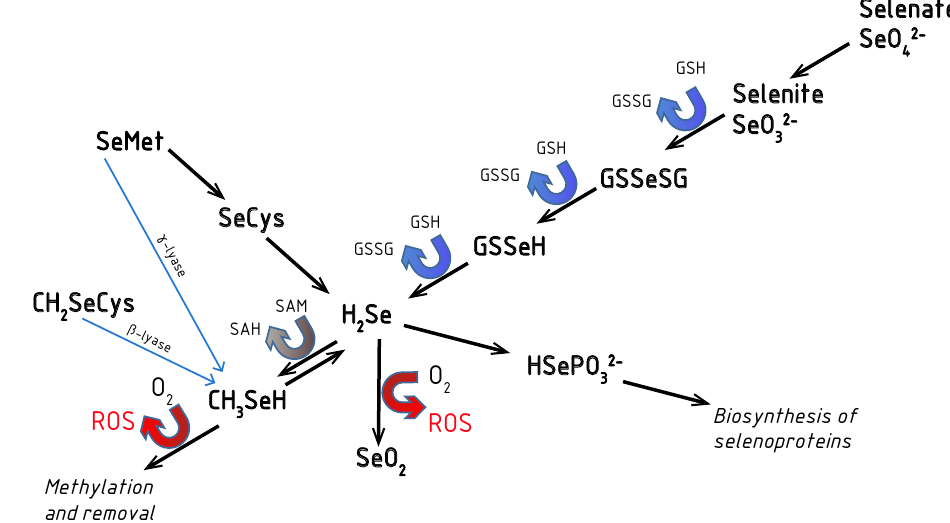
Figure 1. MainmetabolicreactionsoforganicandinorganicSecompoundsinhumans(adaptedfrom [20,21]). H 2 Se is formed during reduction both inorganic (selenate) and organic (SeMet), species. Both SeMet and CH 3 SeCys are enzymatically converted to CH 3 SeH. Glutathione (GSH) or other thiols are used in the reactions, when reduction of inorganic Se species occures. ROS are generated by two presented